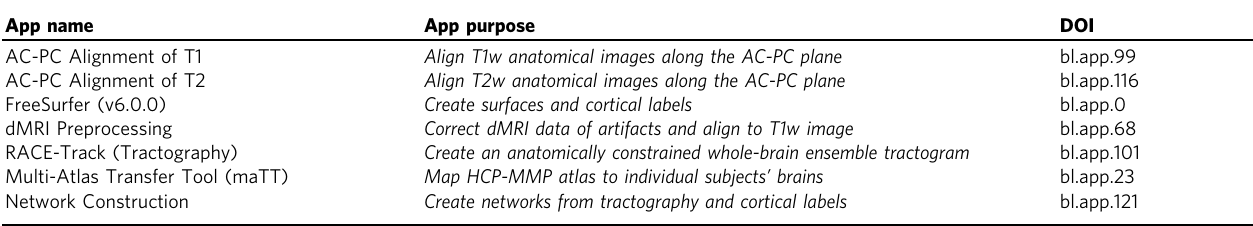
Table 1 Open brainlife.io web services and containerized applications implementing the processing pipeline developed for the current